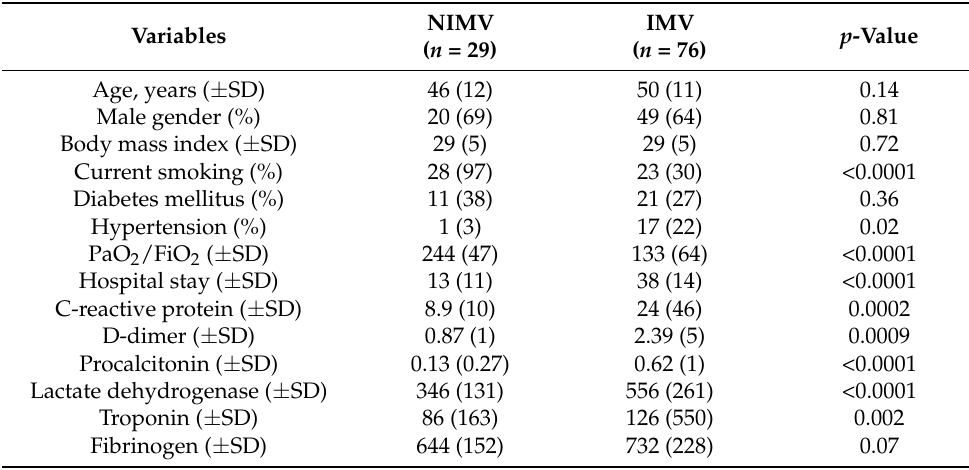
Table 1. Demographic and clinical characteristics of COVID-19